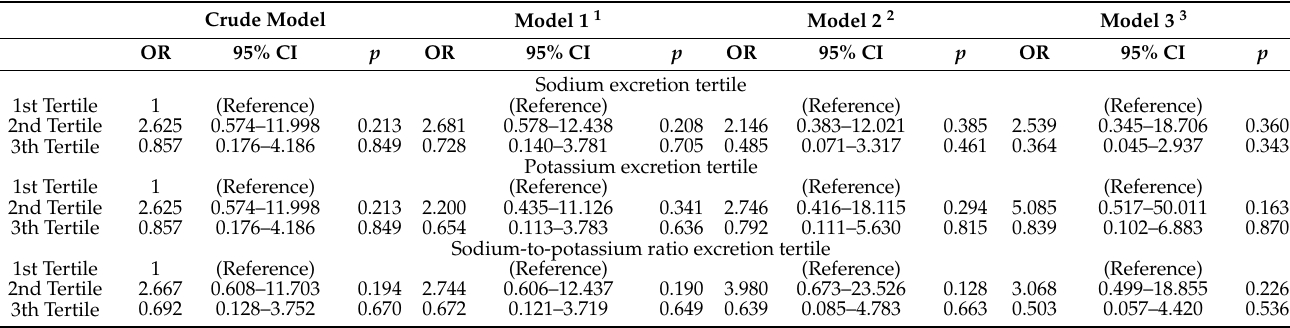
Table 3. Male odds ratios for the association between high adherence to MD and sodium, potassium, and sodium-to- potassium ratio last tertile.